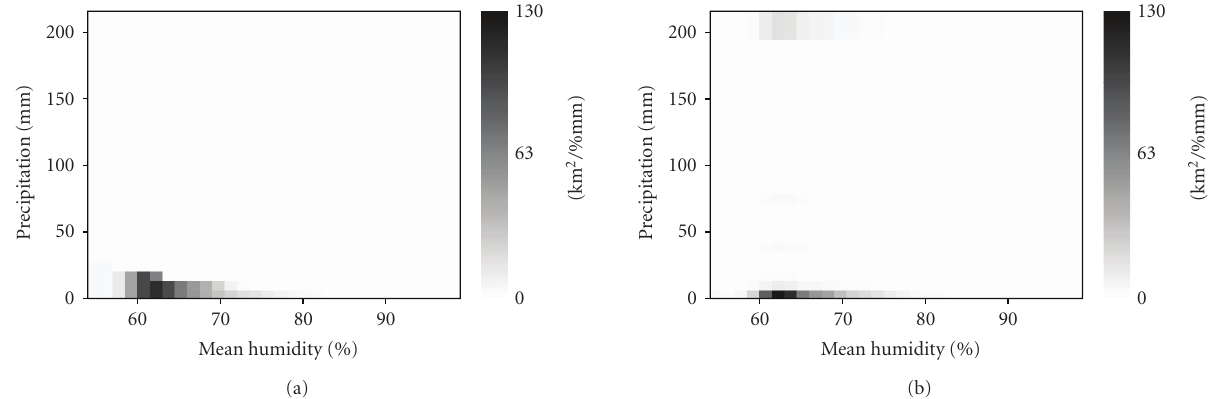
Figure 6: Kernel estimates of daily burn area as a function of mean humidity and precipitation: (a) nonseparable kernel CI estimate; (b) separable kernel CI